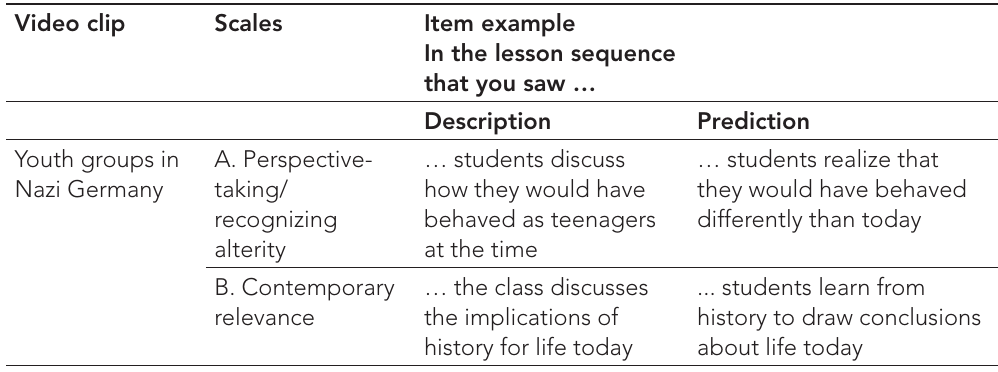
Table 3: Scales and item examples for knowledge-based reasoning Video clip Scales Item example In the lesson sequence that you saw